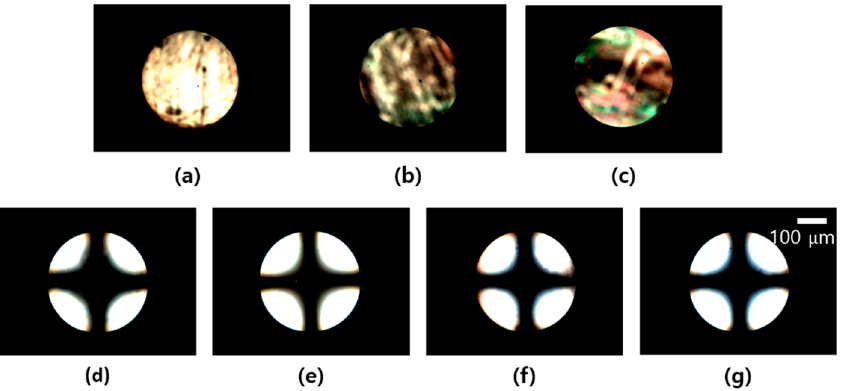
Figure 4. Conoscopic polarized optical microscopy (POM) images of the cells fabricated with PCHA100 films under the following a weight ratio of the PCHA100; 0.01 ( a ), 0.05 ( b ), 0.1 ( c ), 0.5 ( d ), 1.0 ( e ), 1.5 ( f ), and 2.0 wt.% ( g ); scale bar: 100 μ m, all scale bars are the same.